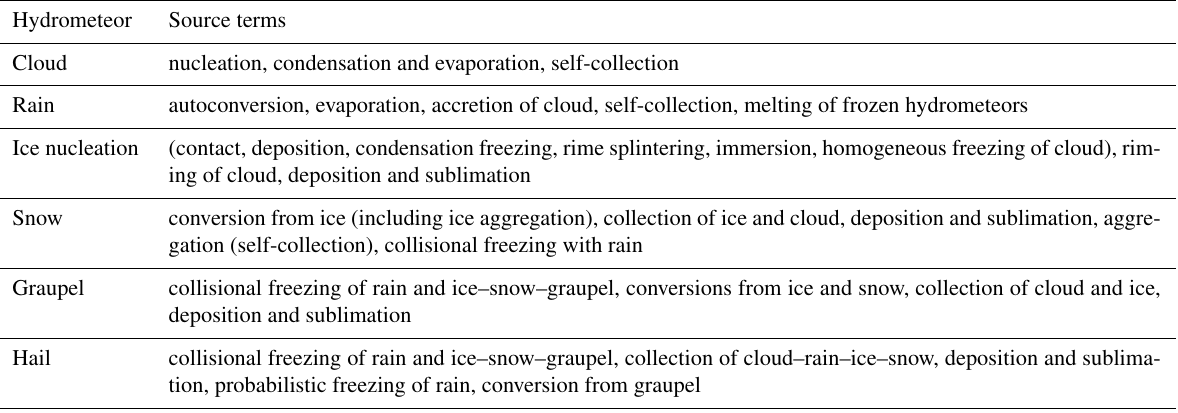
Table 2. Source and sink terms listed according to the hydrometeor category, which gains mass and number, except for self-collections or when the loss is to water